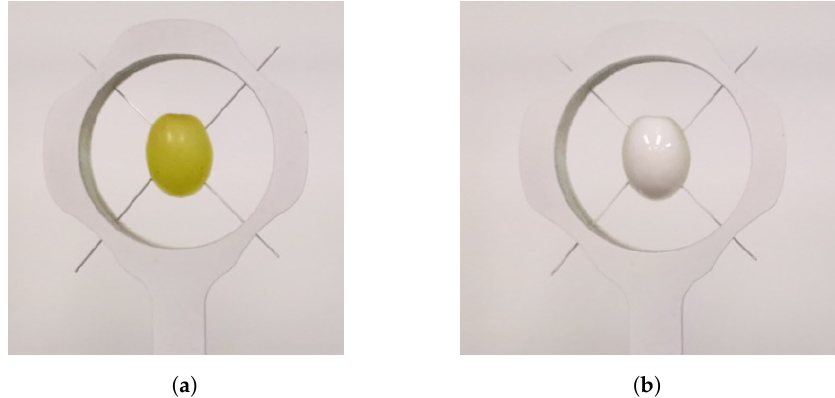
Figure 4. Photos of the setup of scans for a single grape which is first unpainted ( a ) and then painted ( b ). This was performed to analyse the effect of diffused scattering within the grape for the RGB-D cameras, which use ToF and LiDAR